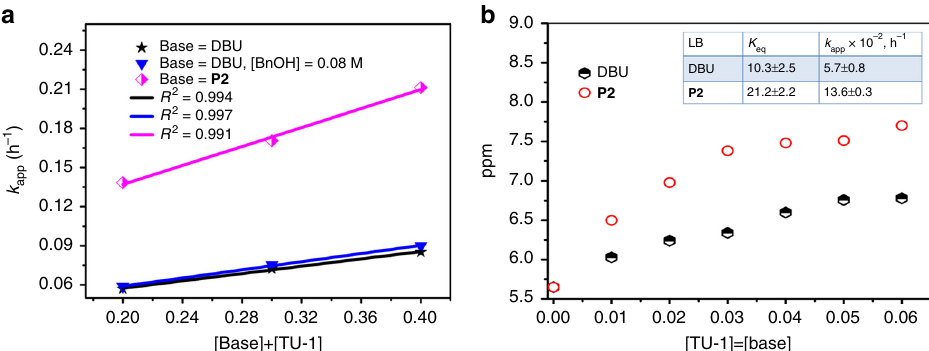
Fig. 4 The determination of the apparent rate constant ( k app ) and the binding constant of TU-1/base pairs. a The plot of the k app vs. [Base] + [TU-1], in neat PO (14.5 M, 14.5 mmol), [TU-1] = [base] = 0.1, 0.15, and 0.2 M; b The plot of the chemical shifts of two binding systems with the concentration of TU-1 and base, [base] = [TU-1] = 0.01 – 0.06 M in CDCl 3 . K eq is the binding constant (at 297 K), and k app is the apparent rate constant. Errors of k app and K eq are